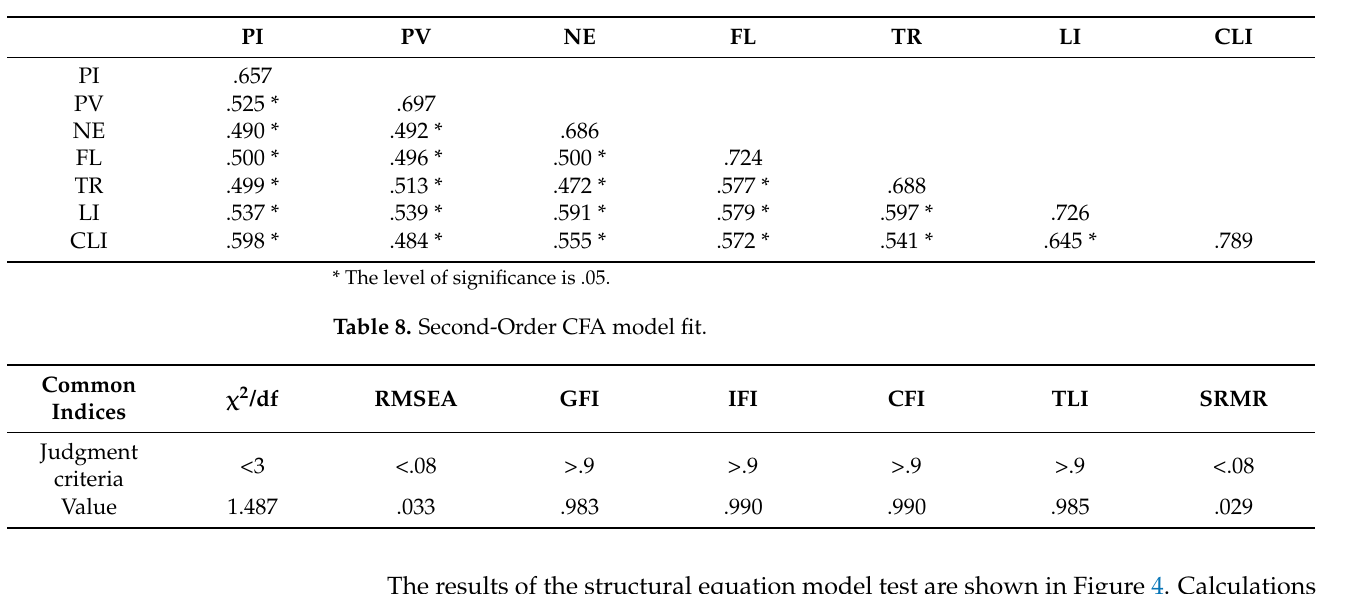
Table 7. Results of discriminant validity tests.